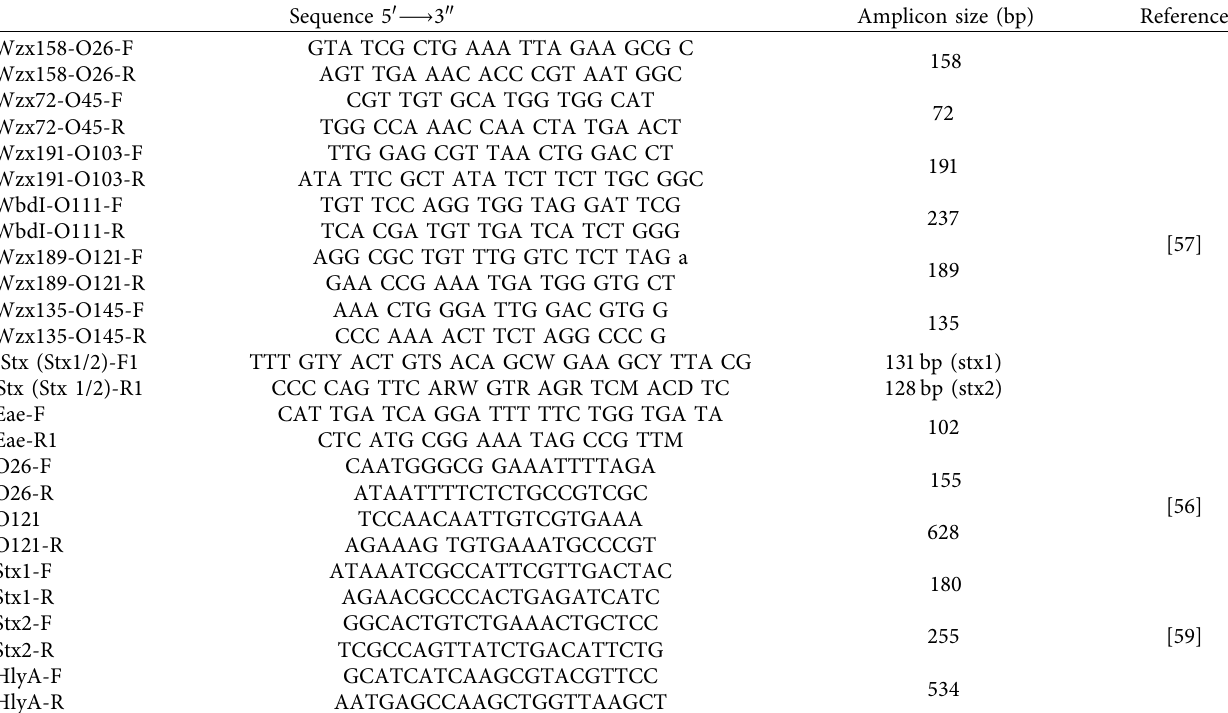
Table 1: Primers used in this